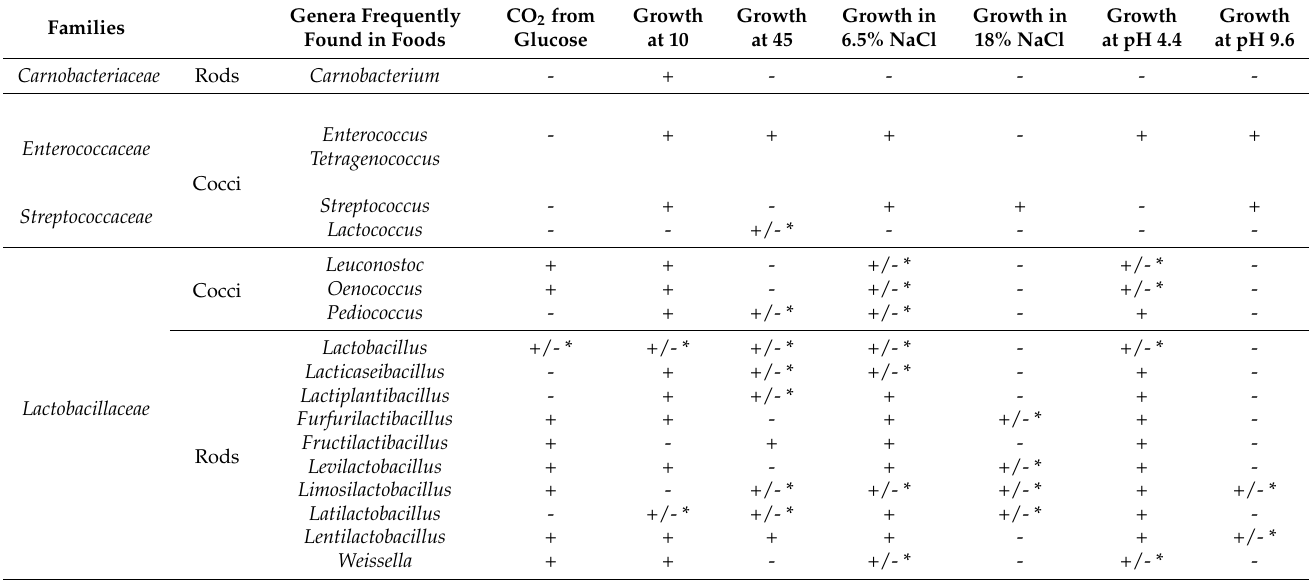
Table 1. Food’s LAB groups and